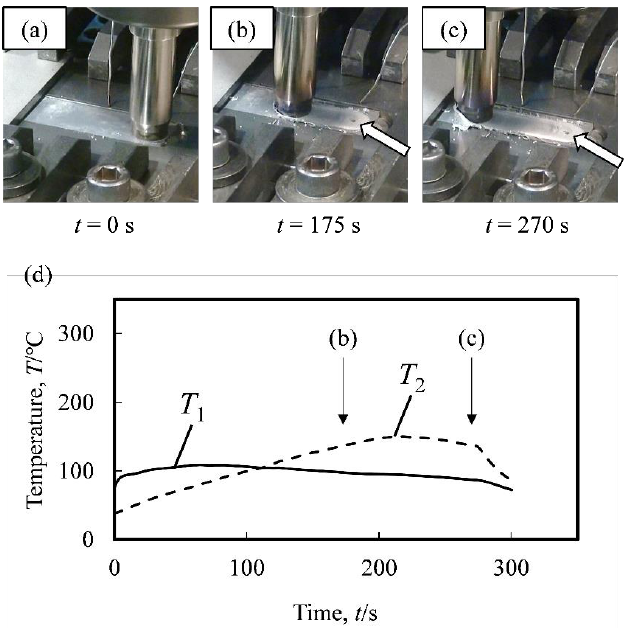
Figure 6. ( a – c ) Tool traversing behavior and ( d ) temperature history during precursor fabrication at v = 10